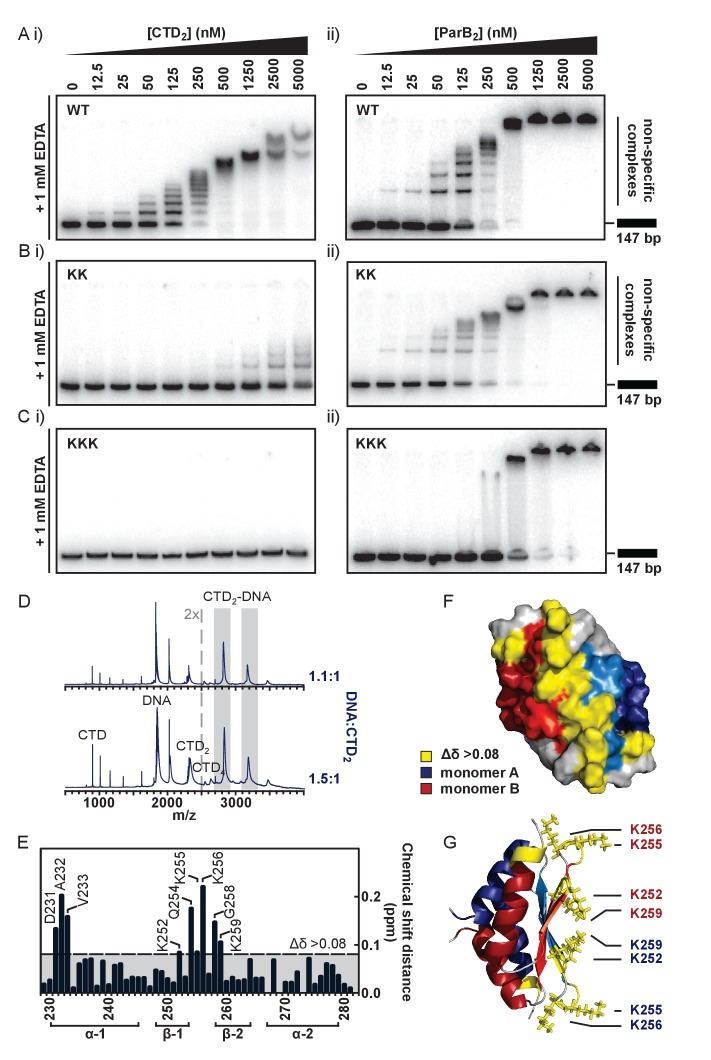
The CTD binds DNA via a lysine-rich surface.(A–C) TBE-EMSAs for the titration of full length ParB and CTD against 147 bp DNA. Wild type and mutant proteins, K255A + K257A and K252A + K255A + K259A, are indicated. (D) Native mass spectrometry. Titrations of a 15 bp nsDNA hairpin against CTD were performed between ratios of 1.1:1 and 1.5:1 DNA:CTD2. Example spectra are shown with the DNA-CTD2 complex shaded in grey. (E) Deviations in the assigned 1H-15N HSQC spectra of CTD upon titration with a 10 bp hairpin DNA. (F) Chemical shift perturbations exceeding 0.08 ∆δ are highlighted on the structure in yellow. (G) Lys residues thought most likely to bind to DNA are shown as sticks.